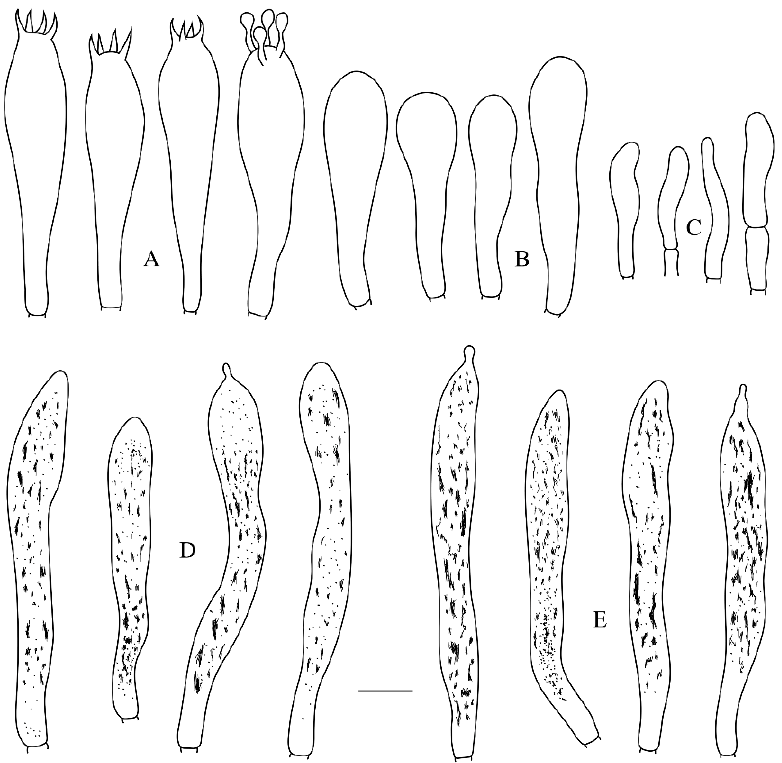
Figure 6. Russula callainomarginis (RITF2639). ( A ) Basidia. ( B ) Basidiola. ( C ) Marginal cells. ( D ) Hy- menial cystidia on lamellae sides. ( E ) Hymenial cystidia on lamellae edges. Scale bar: ( A – E ) = 10 μ m. Basidiospores (6.4–)6.8–7.4–8.0(–8.5) × (5.2–)6.0–6.5–7.1(–7.5) μ m, Q = (1.0–)1.07–1.13– 1.20(–1.31), globose to ellipsoid, ornamentation amyloid; warts bluntly conical to subcy- lindrical, up to 1 μ m high, isolated or connected with lines or ridges; suprahilar plage distinct, weakly amyloid. Basidia (40.0–)42.4–46.4–50.5(–52.0) × (10.2–)11.1–12.0–12.9(– 13.6) μ m, mostly 4-spored, clavate or narrowly clavate; basidiola mainly clavate, ca. 8–13